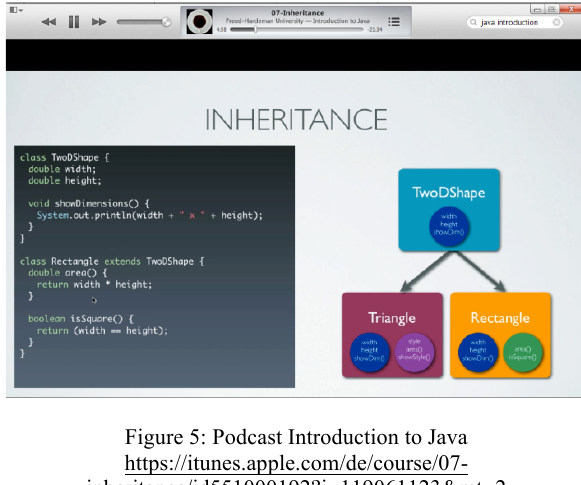
Figure 5: Podcast Introduction to Java